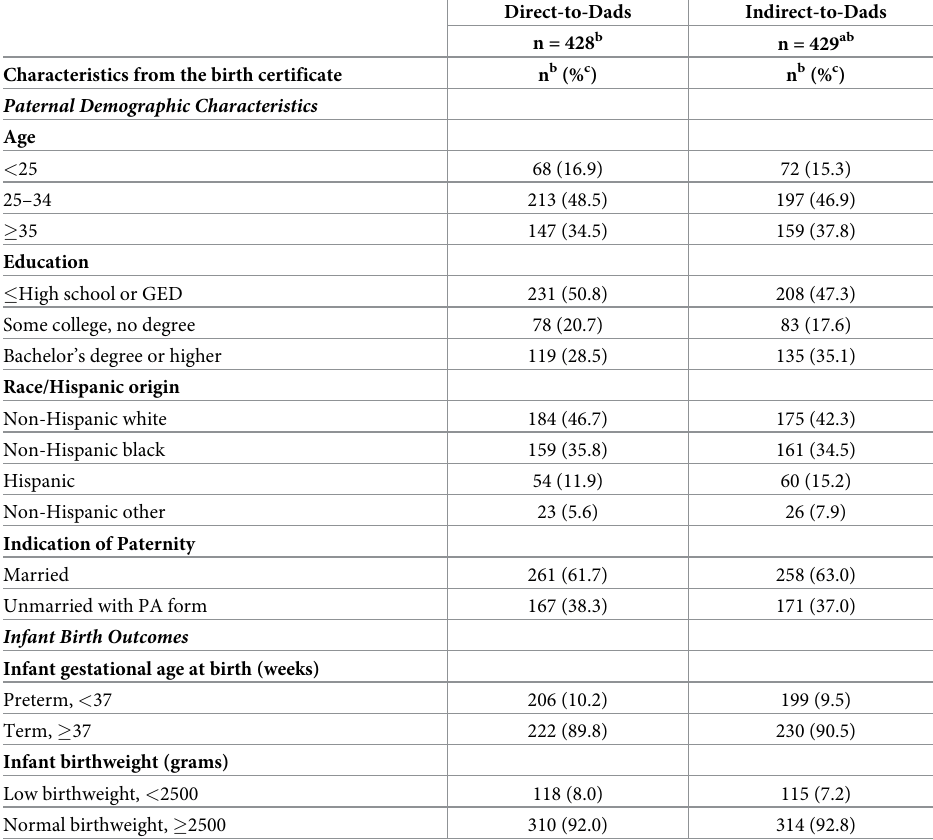
Table 2. Distribution of select characteristics from the birth certificate: Comparison between study arms a —Total sampled fathers–the Pregnancy Risk Assessment Monitoring System for Dads study, October 2018-July 2019, Georgia, USA.